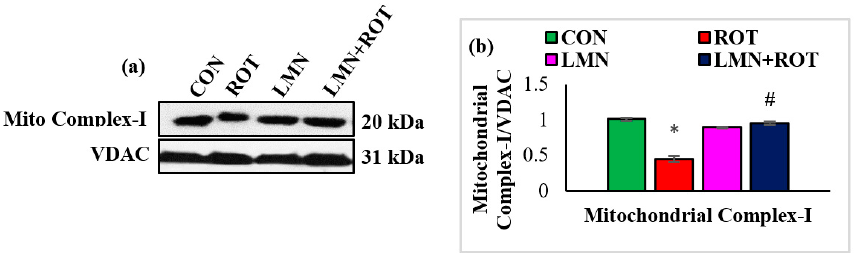
Figure 9. Western immunoblotting and densitometric analysis on the protein expression of mitochon- drial complex-I in the striatal tissues of rats ( a , b ). Immunoblotting was performed in duplicate and the values are presented as mean ± SEM. * p < 0.05 CON vs. ROT; # p < 0.05 ROT vs. LMN + ROT (one-way ANOVA followed by DMRT). CON: normal control, ROT: rotenone, LMN: limonene, LMN + ROT: limonene and rotenone treatment.